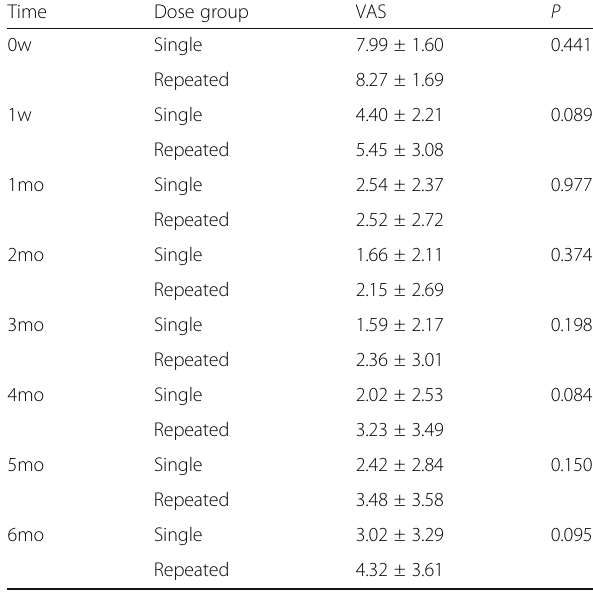
Table 4 VAS scores at baseline and during the 6-month follow-up Time